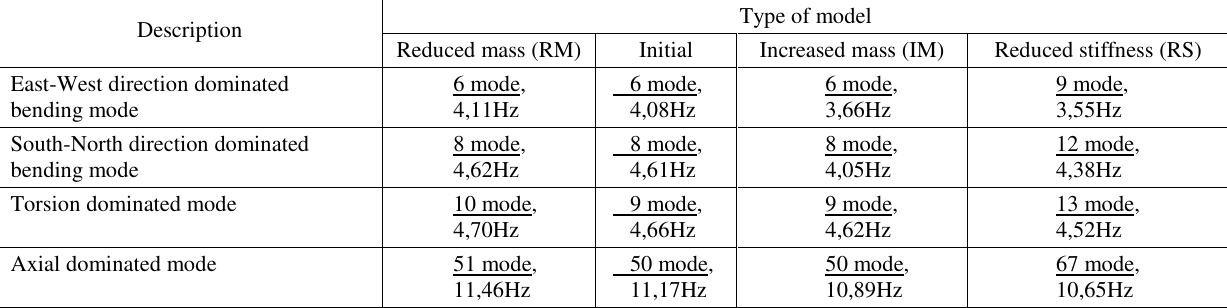
Table 1. Comparison of frequencies for different